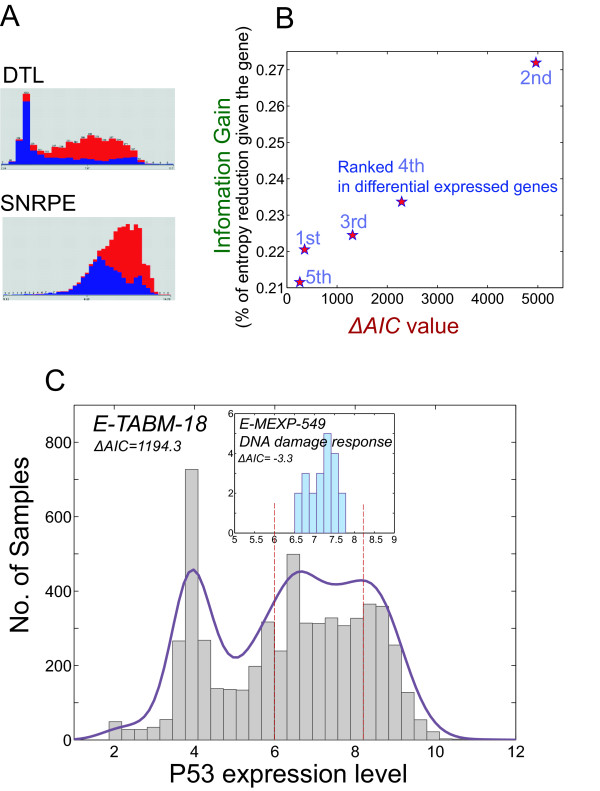
Application in human microarray dataset. A) Comparison of the differentially expressed genes (with respect to cancer/non-cancer phenotypes) with high and low ΔAIC values. In the histograms, the red bars are cancer samples and the blue bars are non-cancerous samples. B) The relationship between information gain and ΔAIC value for the top 5 differentially expressed genes. C) A histogram of p53 expression levels in ~6000 sample dataset (E-TABM-18) as compared with a small sample-size dataset (E-MEXP-549, see insert).